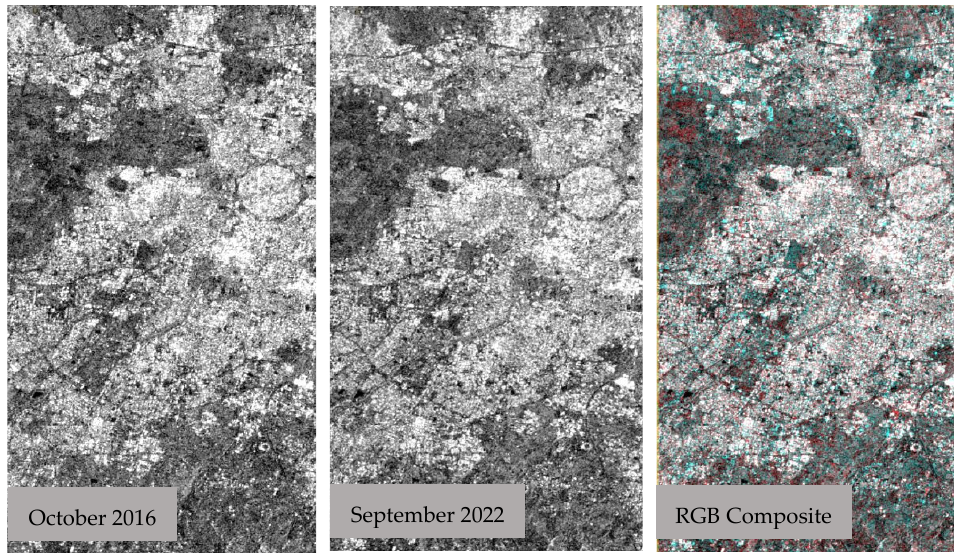
Figure 10. Visualization of Changes in Nicosia—RGB Composite.